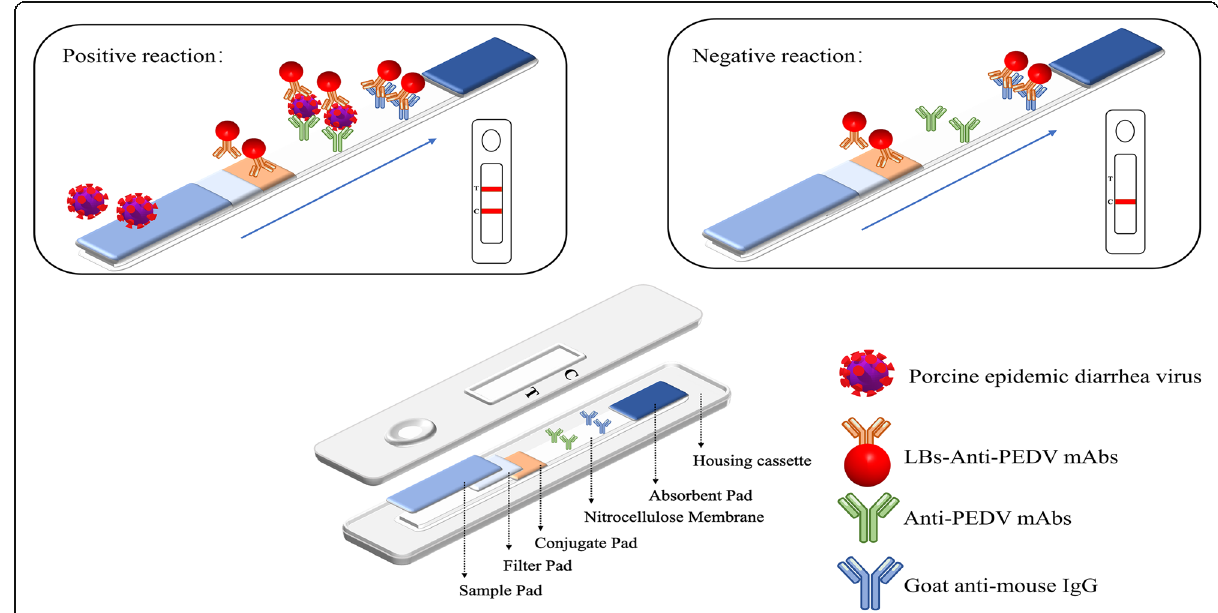
Fig. 1 Schematic of PEDV detection using the LBs-LFIA. PEDV , porcine epidemic diarrhea virus